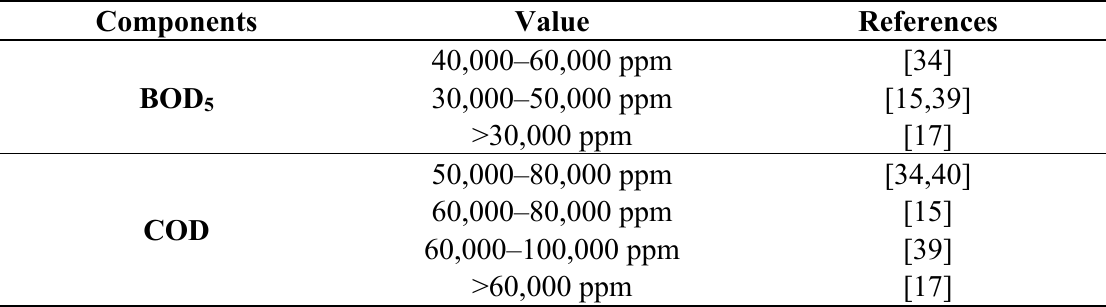
Table 2. Organic load of cheese